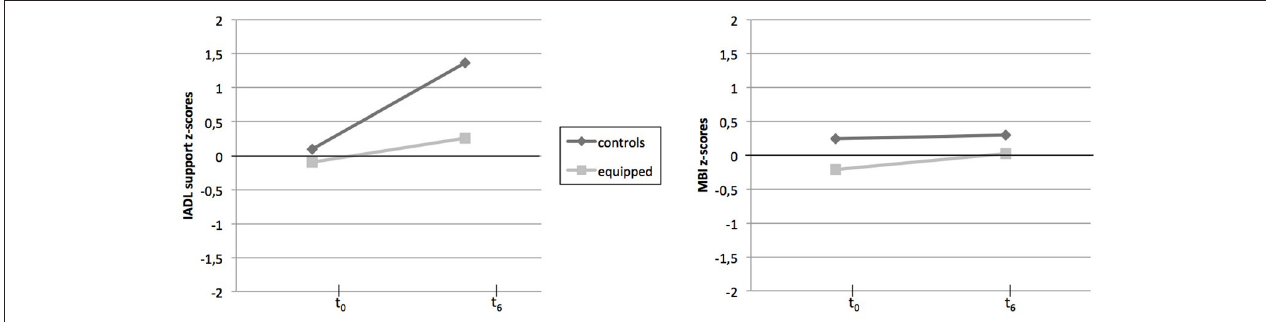
FIGURE 4 | Pre- and Post-intervention z-sores of caregiver burden measures for each group. M, mean; SD, standard deviation, IADL, Instrumental Activities of Daily Living; MBI, Maslasch Burnout Inventory.